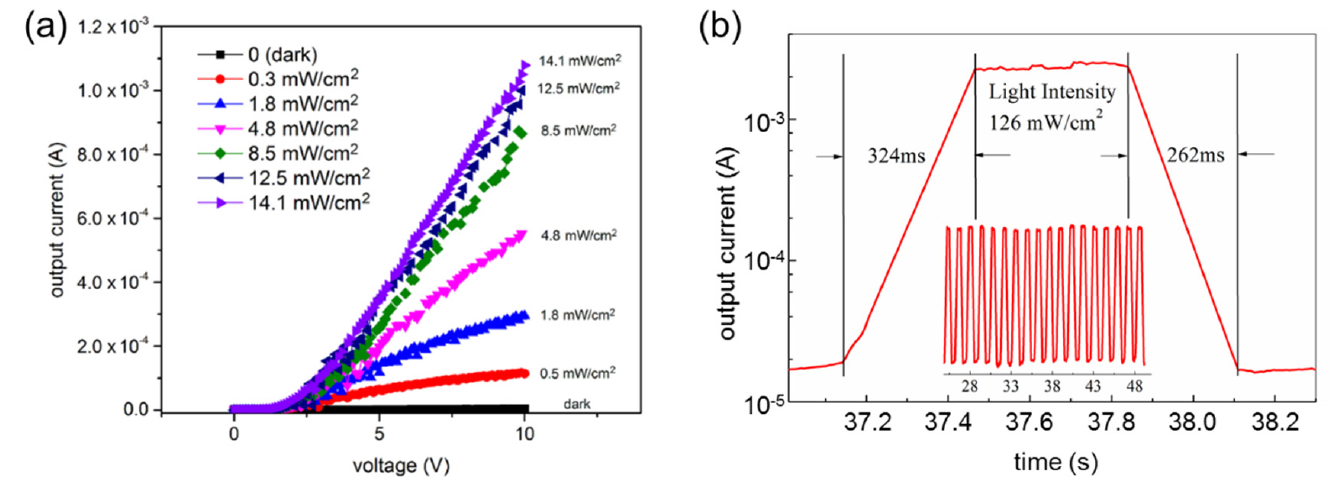
Figure 4. ( a ) Output characteristics of the bottom − mode photodetecting device with 20 nm of Ag film annealed at 400 °C with a 500 μ m electrode channel width. Output currents were measured under visible light illumination with various intensities of 0.0 (dark), 0.5, 1.8, 4.8, 8.5, 12.5, and 14.1 mW/cm 2 . ( b ) Real-time characteristics of the output current measured in response to a light intensity of 14.1 mW/cm 2 at a constant sample bias voltage of 10 V. The data clearly show the reversible pho- toresponsivity of the device.